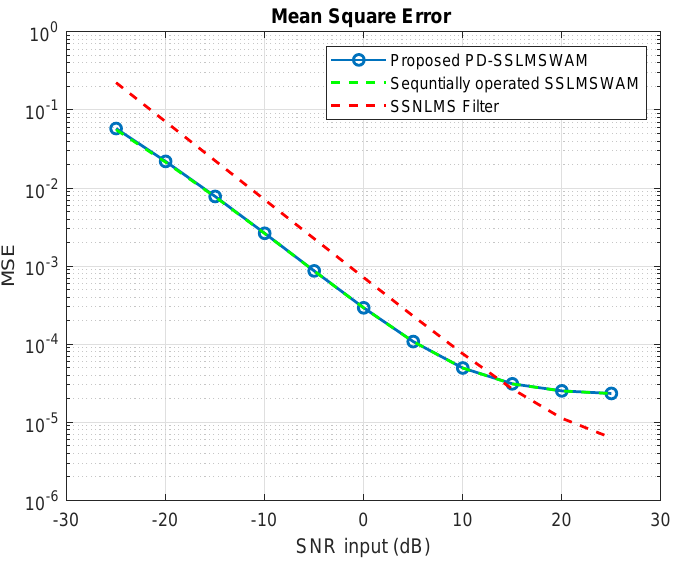
Figure 17. Mean square error